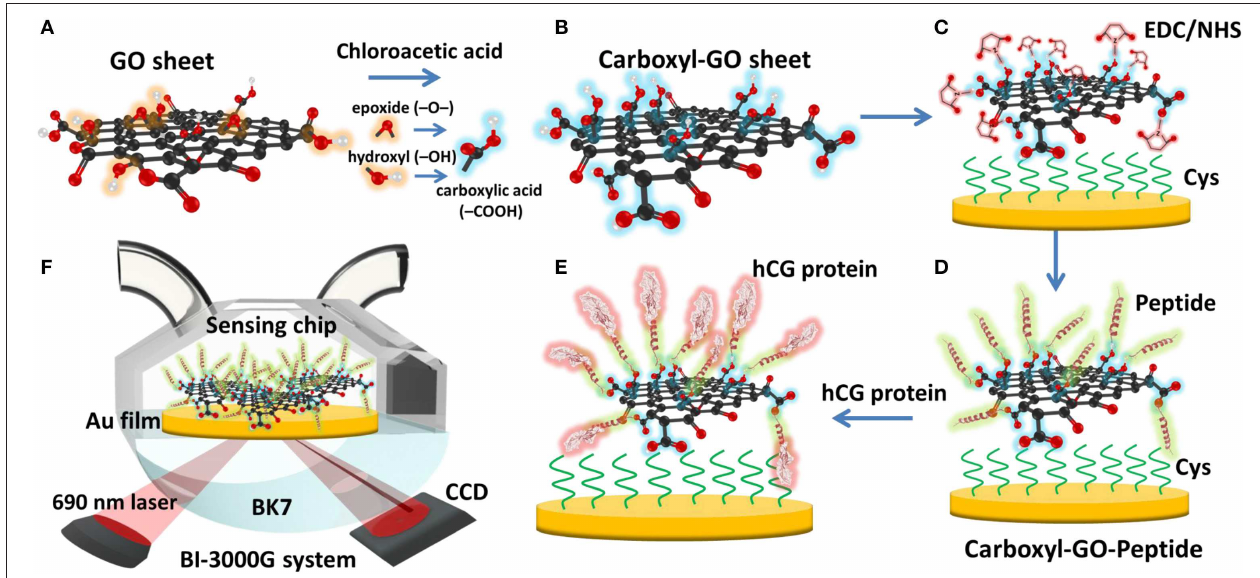
FIGURE 8 | Schematic illustration of the conversion of (A) GO into (B) carboxyl-GO sheets via a facile one-step chloroacetic acid modification route. (C) GO surface activation with EDC/NHS. (D) The attachment of peptides via amine coupling and the deactivation of the unreacted surface sites. (E) Immobilization of the peptide on the carboxyl-GO–based SPR chip using non-immunological to detect hCG protein. (F) Schematic instrumental setup of the Kretschmann configuration. Figures (A–F) were reproduced from Chiu et al. (2019a) with permission from Dove Medical Press.